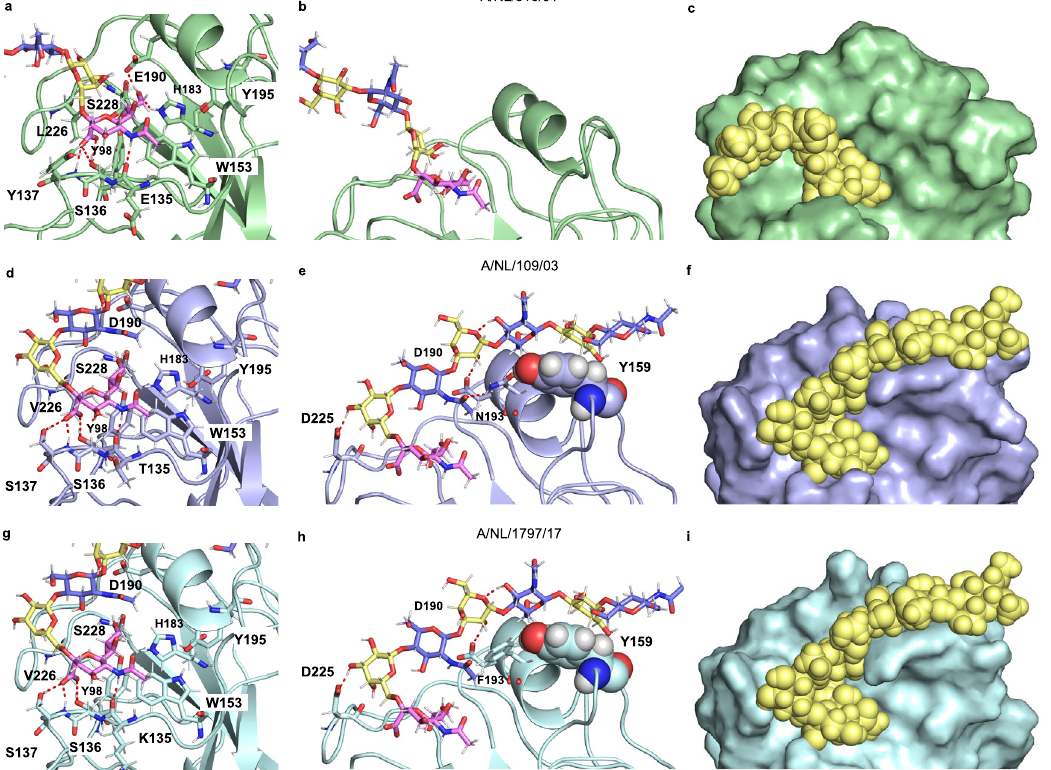
Fig. 3 Structural comparison of HAs from evolutionary different strains in complex with extended glycan receptor. Details of the sialic acid binding sites are shown for A/NL/816/91 ( a ), A/NL/109/03 ( d ), and A/NL/1797/17 ( g ). The interactions of the poly-LN chain with the protein are shown for A/NL/ 816/91 ( b ), A/NL/109/03 ( e ), and A/NL/1797/17 ( h ). The surface and spheres representations of HA/glycans complexes are shown for A/NL/816/91 ( c ), A/NL/109/03 ( f ), and A/NL/1797/17 ( i